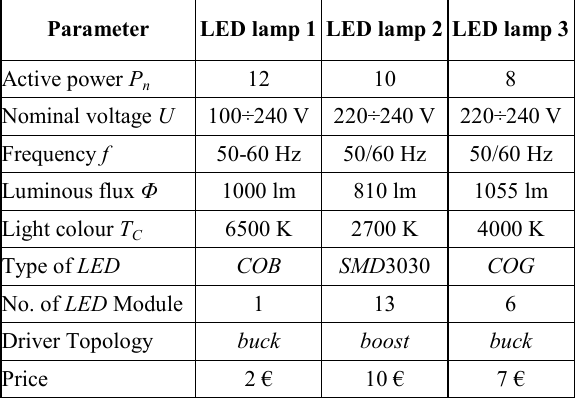
Table 1. Catalogue parameters of the LED lamps with E27 screw base selected to the research